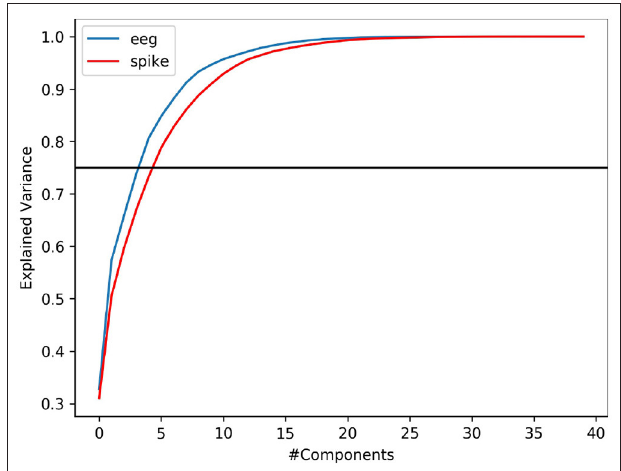
FIGURE 5 | PCA-based variance explanation of EEG signal (blue line) and its corresponding spike representation (from LIF; red line) for ERN dataset. Blackline represents the 75% variance. Spike-representation (from LIF) was able to extract a more independent eigenvector from EEG signal to account for a given fraction of variance in the dataset.